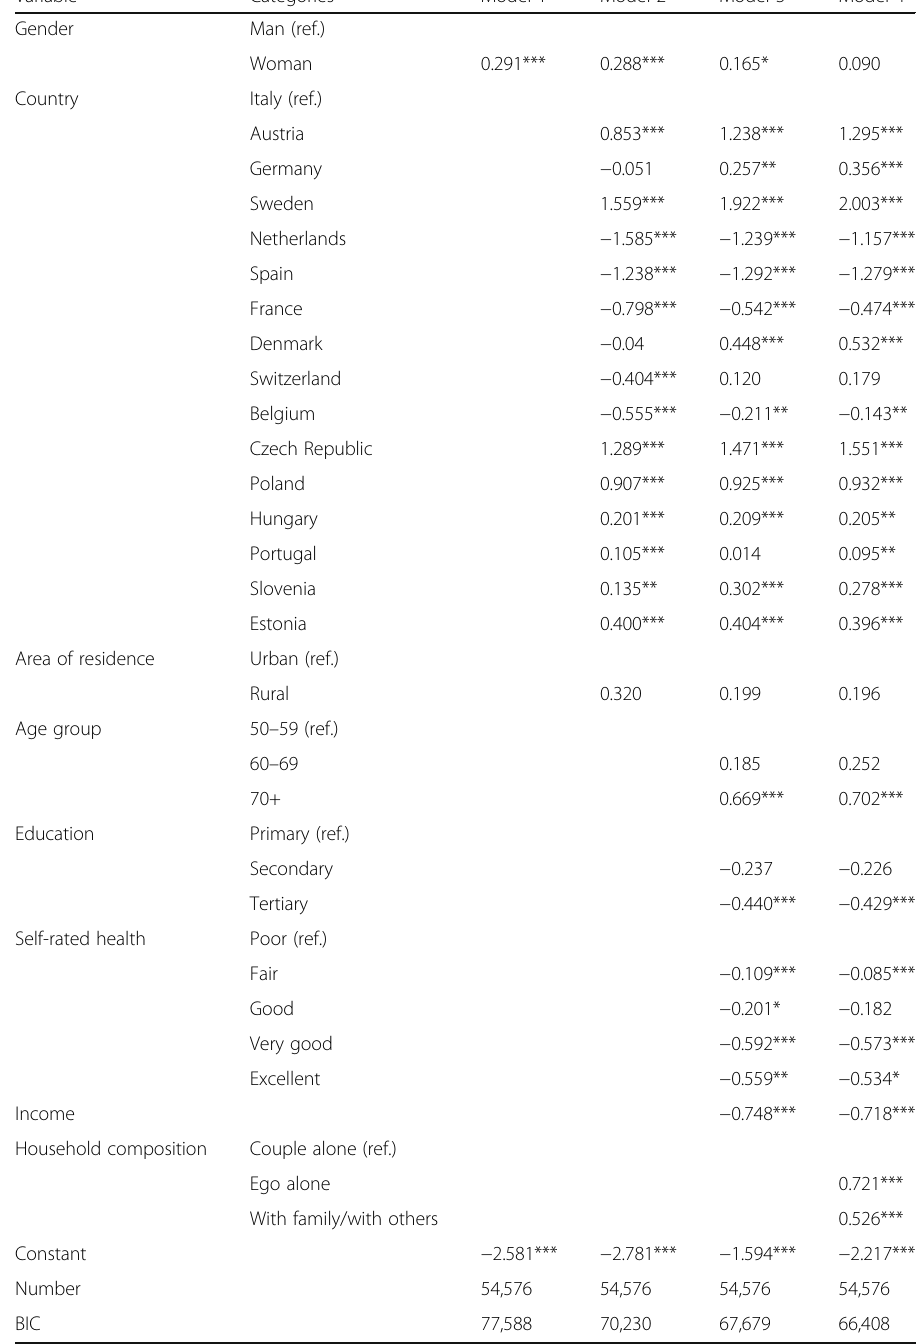
Table 2 Multinomial regression models predicting the exclusion from home ownership (rent-free versus